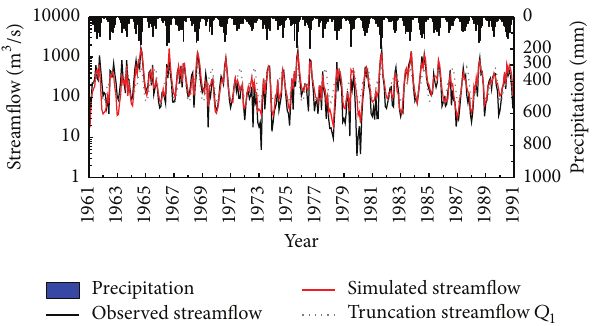
Figure3:ObservedandsimulatedmonthlyhydrographsatHuaxian